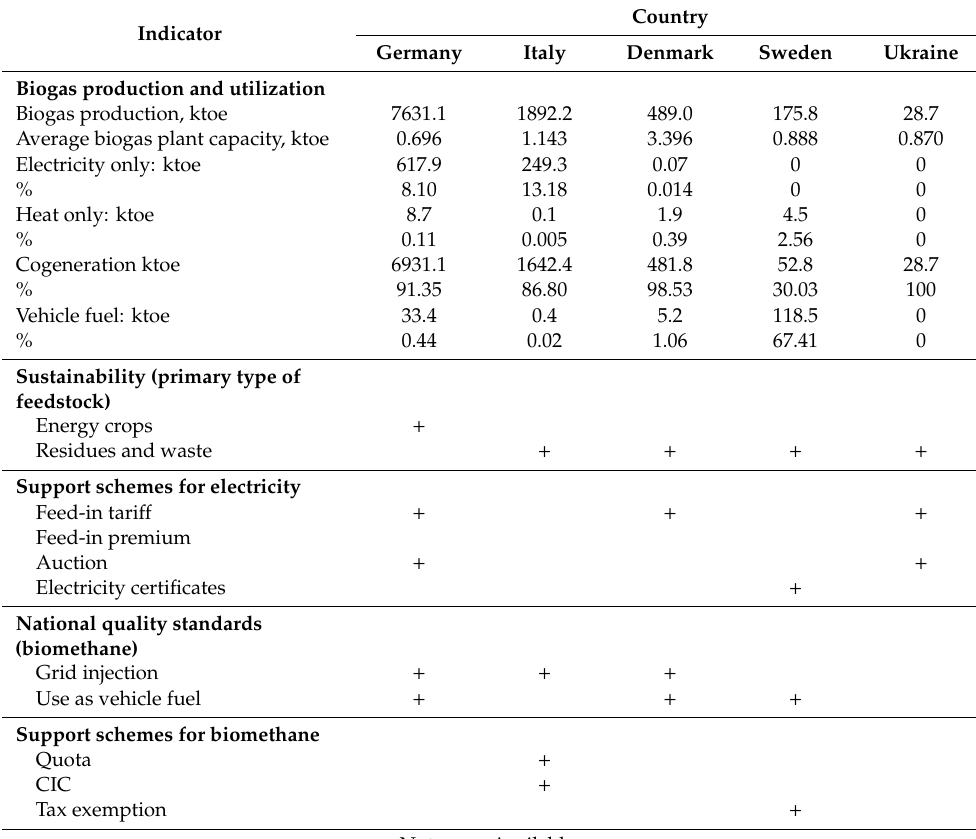
Table 4. Market comparison. CIC, Certificates of Release for